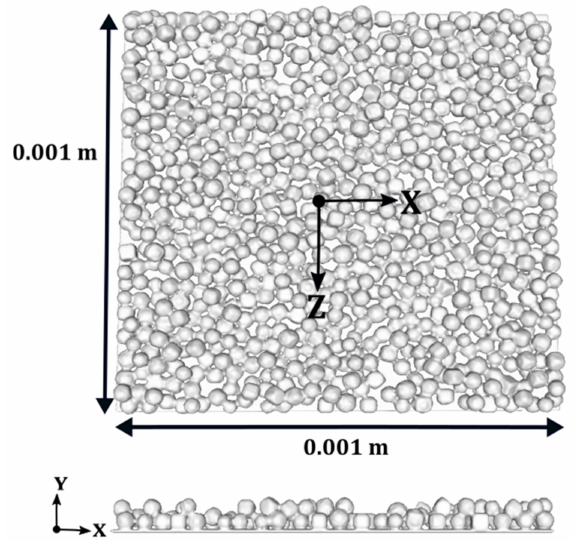
Figure 3. Plan view and cross-sectional view of the initial powder bed configuration. The bed contains super-quadric Ti-6Al-4V powder grains with a size distribution of 35–40 µ m diameter. The initial temperature for the build plate and powder bed is assumed to be ambient (T 0 = 300 K). The initial microstructure composition is assumed to be fully